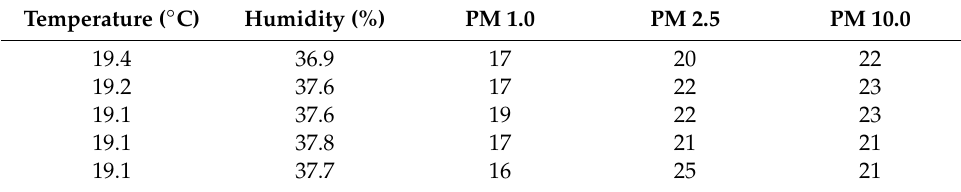
Table 2. Temperature, humidity and particulate matter data collected in experiment.